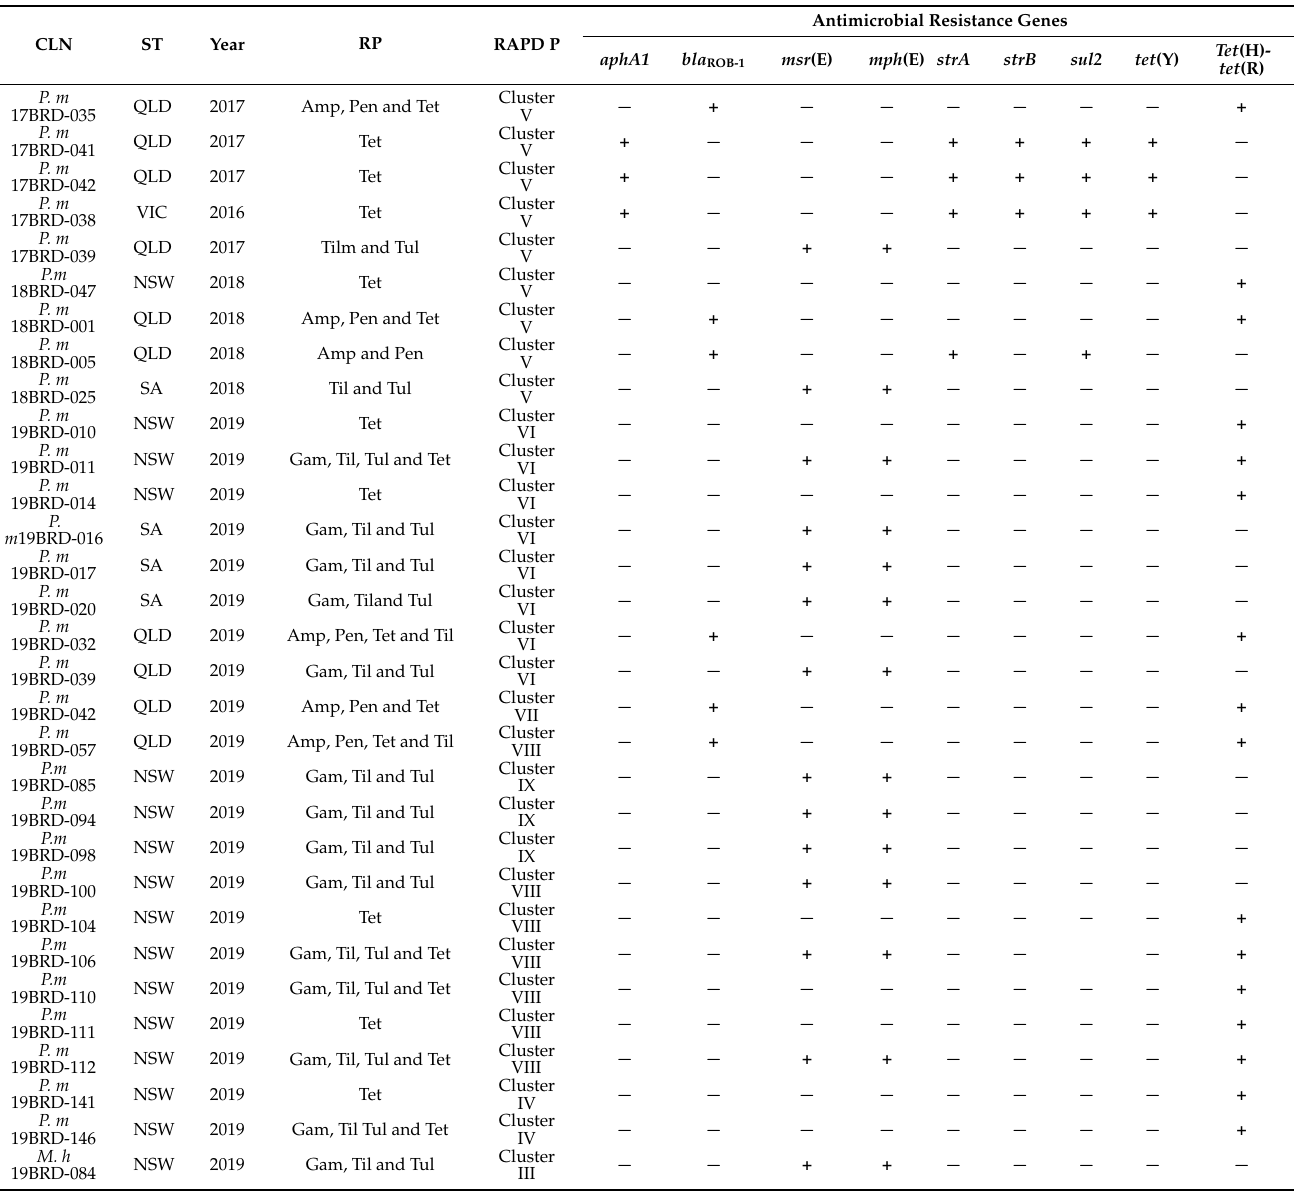
Table 8. Resistance profile, RAPD pattern and presence of antimicrobial resistance genes among isolates of Pasteurella multocida (P. m) ( n = 28) and Mannheimia haemolytica (M. h) ( n = 1) +, present, − ,